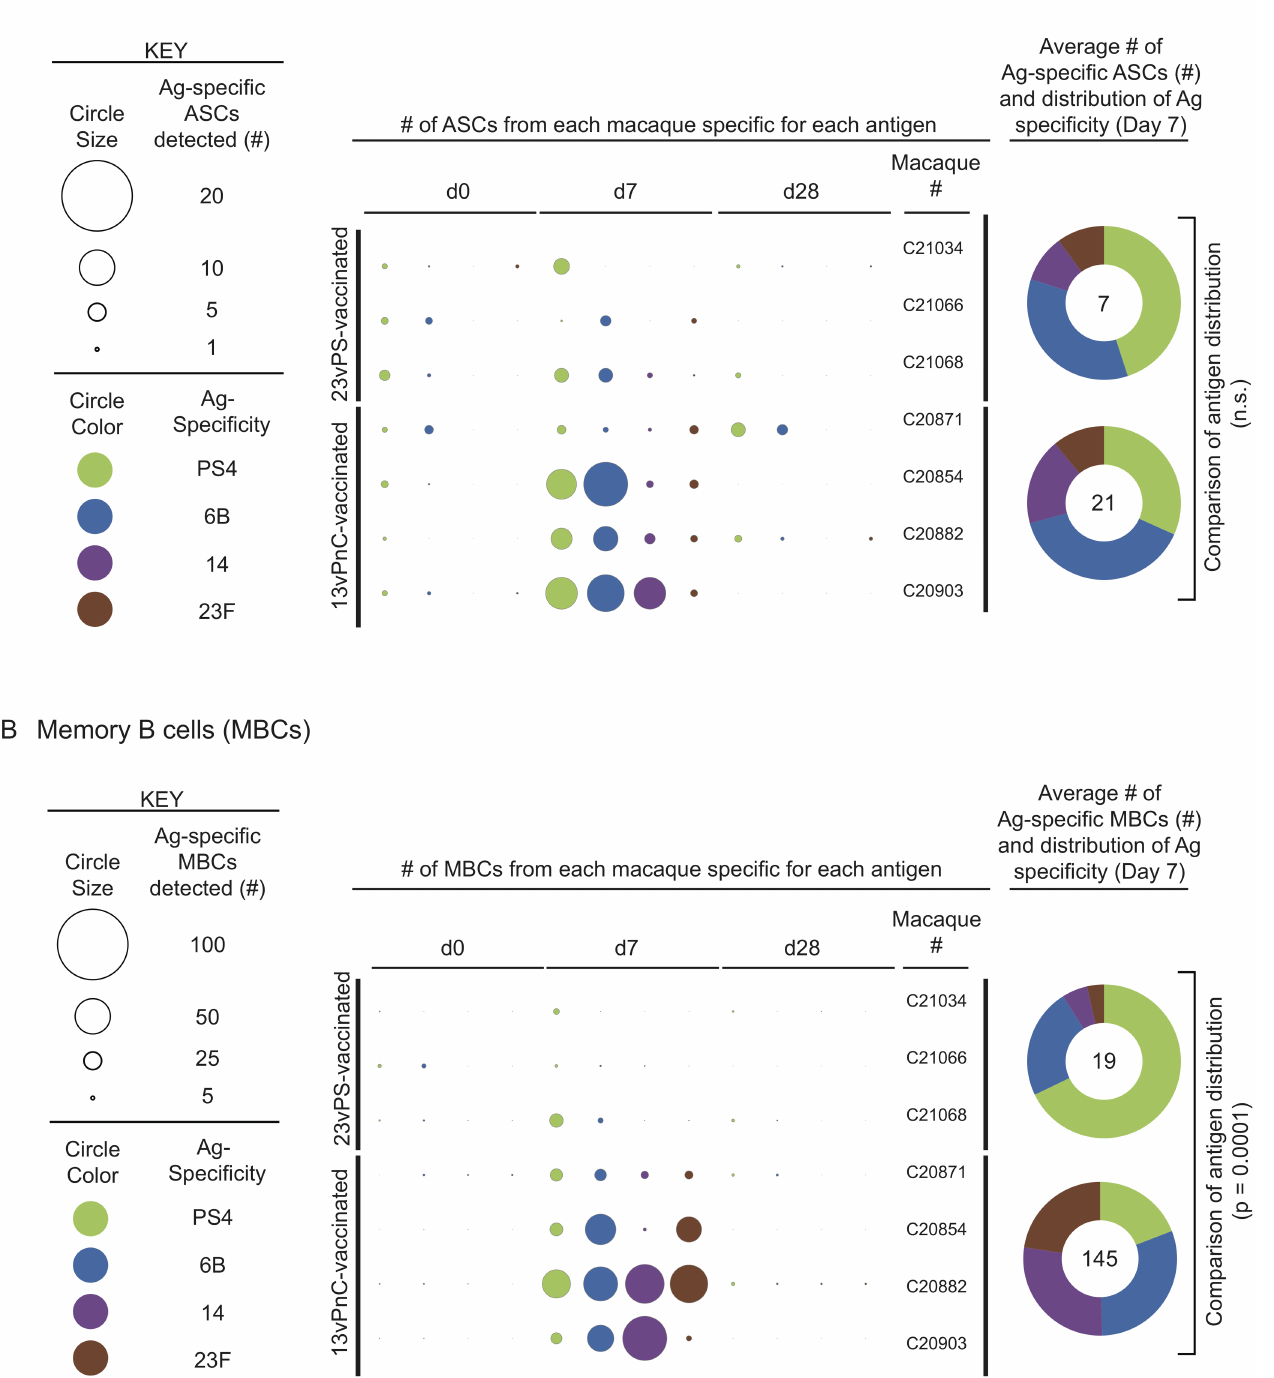
PLOS ONE | https://doi.org/10.1371/journal.pone.0183738 September 14,